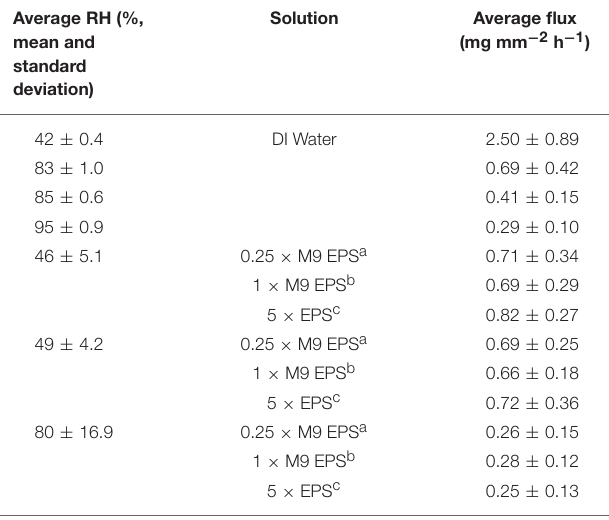
TABLE 2 | Average water flux for evaporative flux experiments performed at (a) pseudo steady state of water at four different relative humidity (RH) and at (b) three different RH for each of three different EPS solutions.